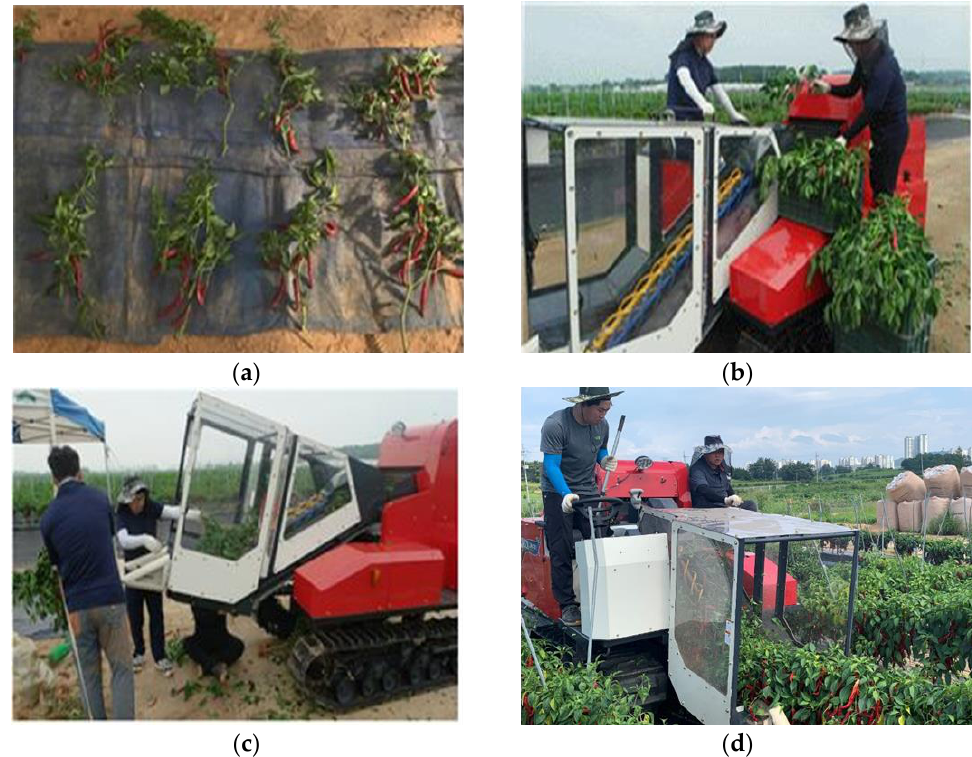
Figure 5. Picture of the ( a ) pepper plants samples, ( b ) non-moving status during non-picking operation, ( c ) non-moving status during picking operation, and ( d ) moving status during picking operation.